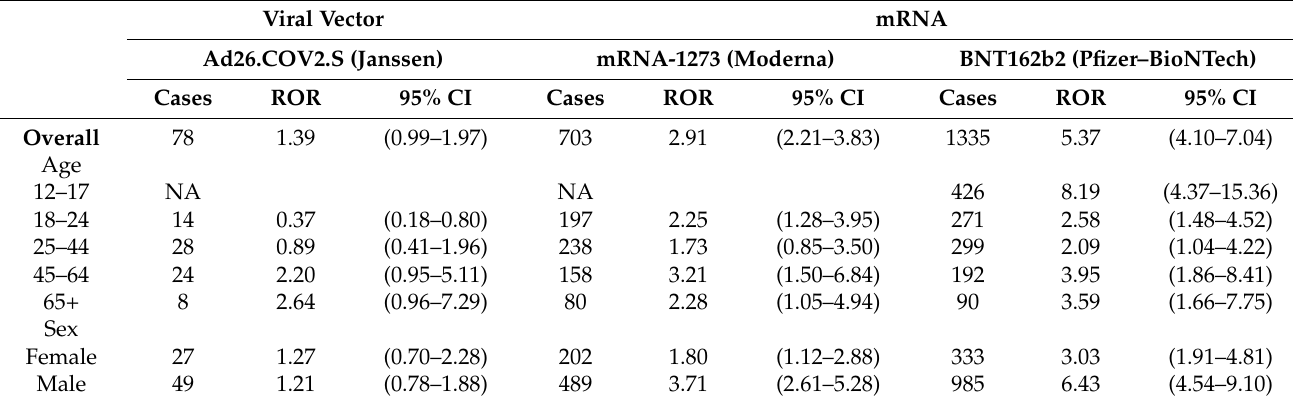
Table 2. Myocarditis/pericarditis following COVID-19 vaccination compared to all other vaccines from VAERS by age and sex. Viral